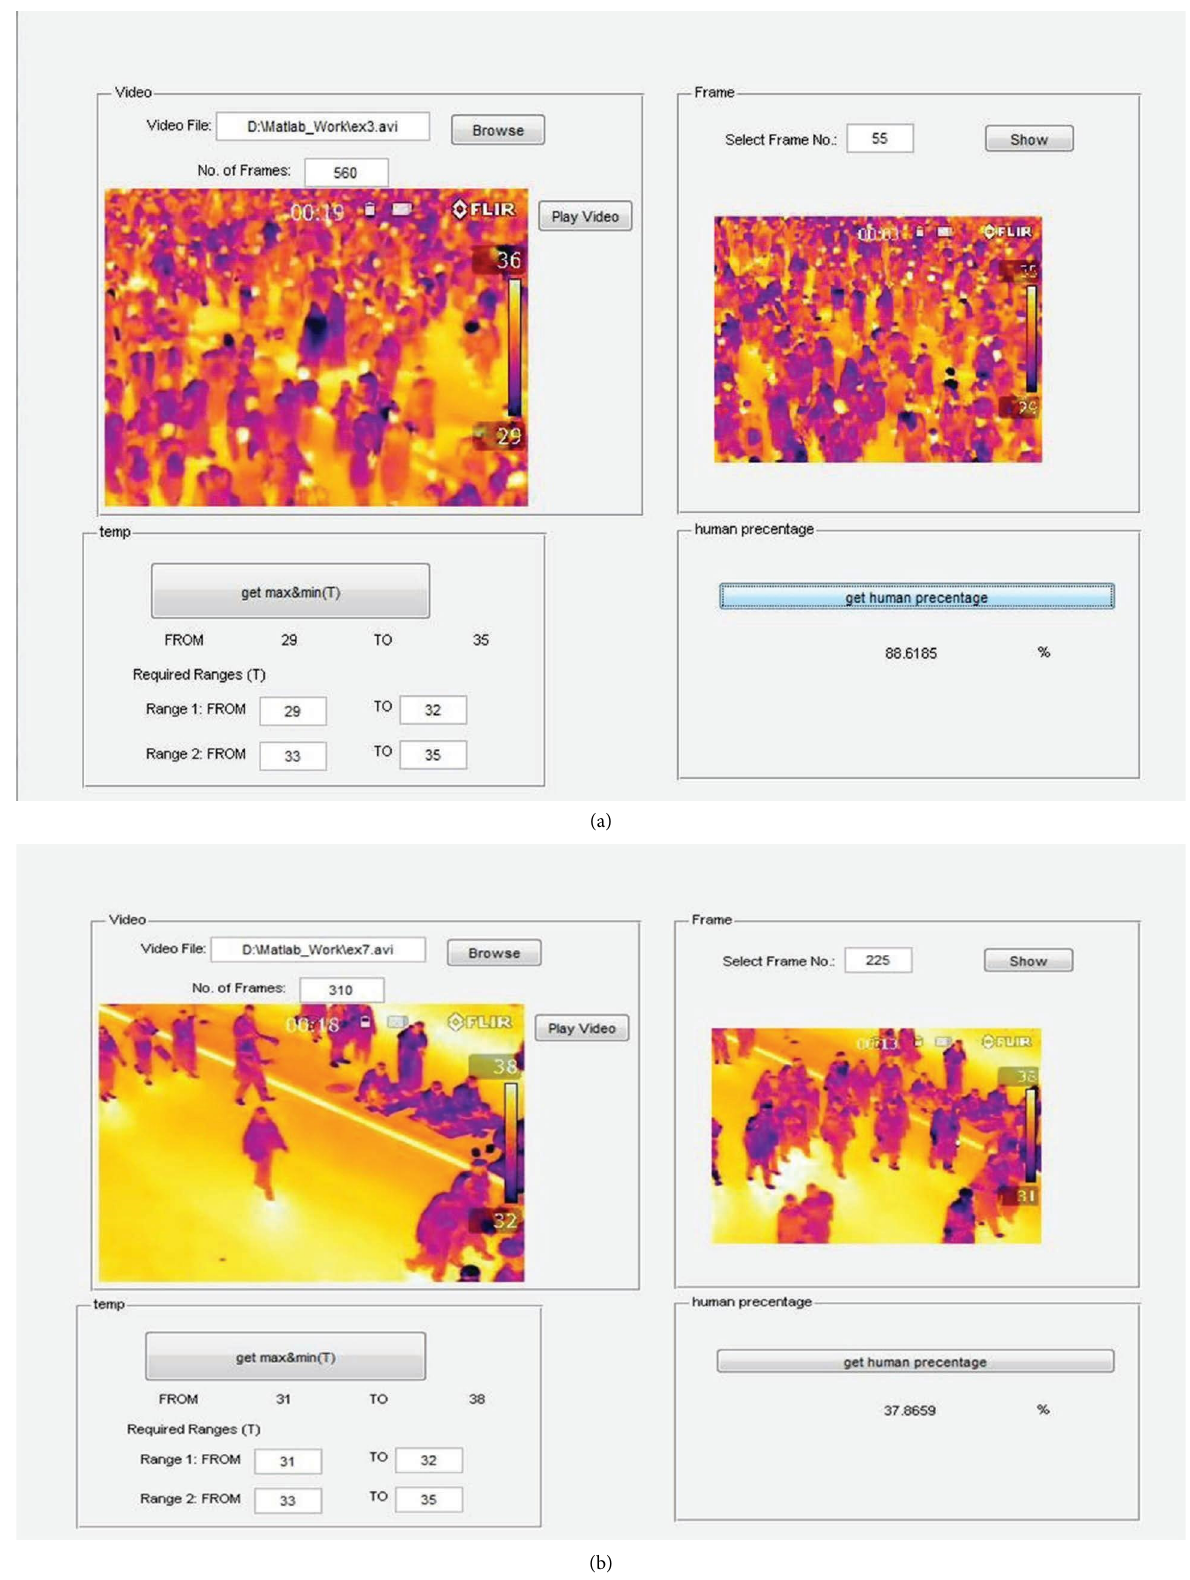
Figure 11: (a), (b) Samples for using two (covered and uncovered) ranges,